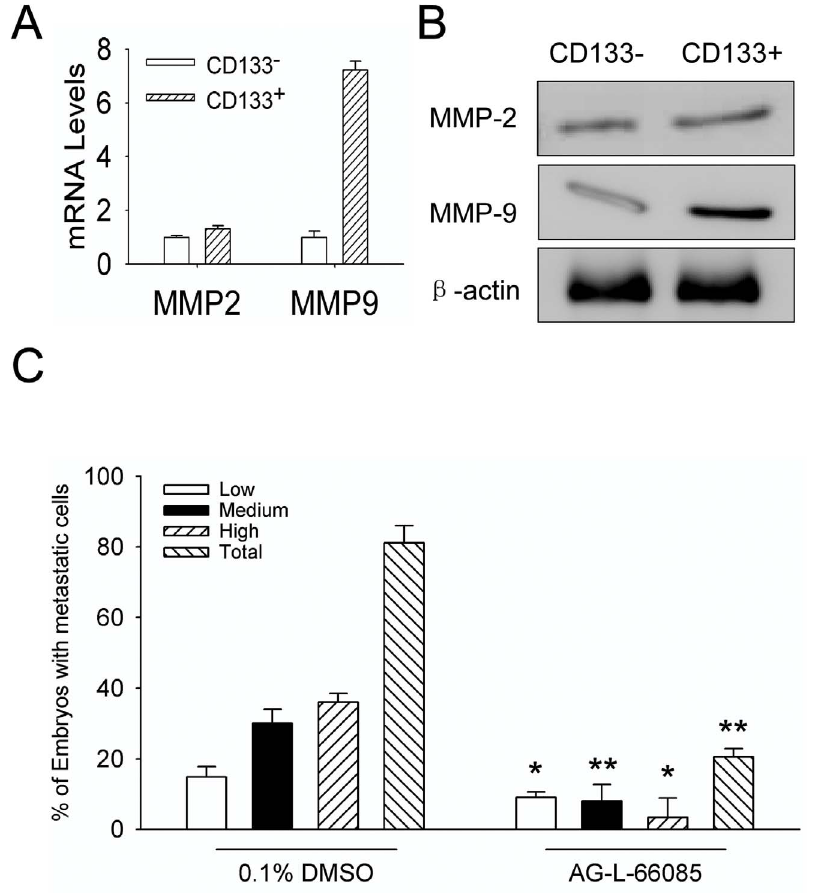
Figure 5. MMP-9 mediates invasion and spread of CD133 + U87 GSCs in zebrafish embryos. A. The MMP-2 and MMP-9 RNA in CD133 2 U87 cells and CD133 + U87 GSCs were examined by qRT-PCR. B. The MMP-2 and MMP-9 proteins in CD133 2 U87 cells and CD133 + U87 GSCs examined by Western blot. C. The inhibitory effect of MMP-9 inhibitor (AG-L-66085) on the invasion of CD133 + U87 GSCs within zebrafish embryos. The embryos xenografted with CD133 + U87 GSCs were treated with 2 m M AG-L-66085 or DMSO control. The percentages of invasive cells in injected embryos (low, medium, or high-invasion) were measured at 2 dpi. The data were obtained from three replicate experiments with the number of embryos: n=123 for DMSO control group, n=119 for MMP-9 inhibitor group, and n=144 for negative control group ( p ,